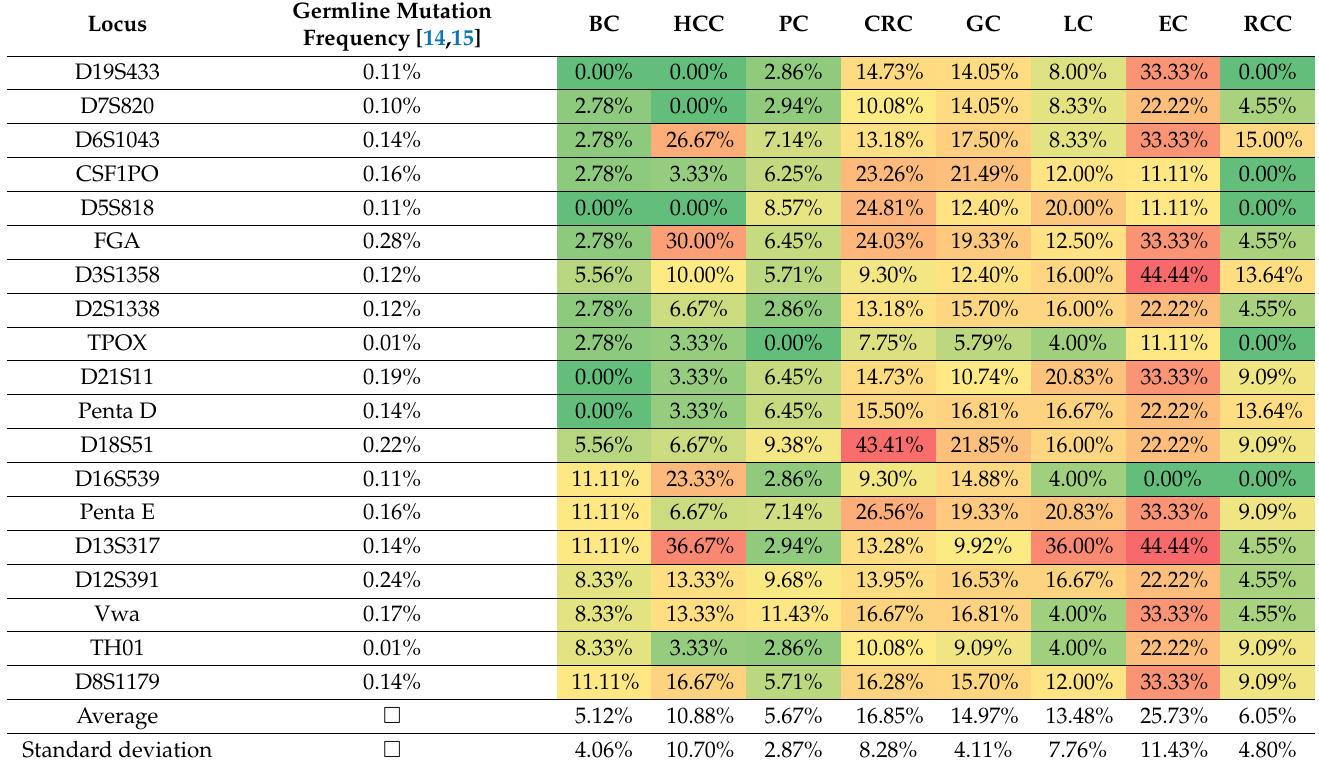
Table 1. STR alterations in each of the loci in the 407 paired tumor samples. The background color of green indicated low mutation frequency, and it turned to red when the mutation frequency grew higher.